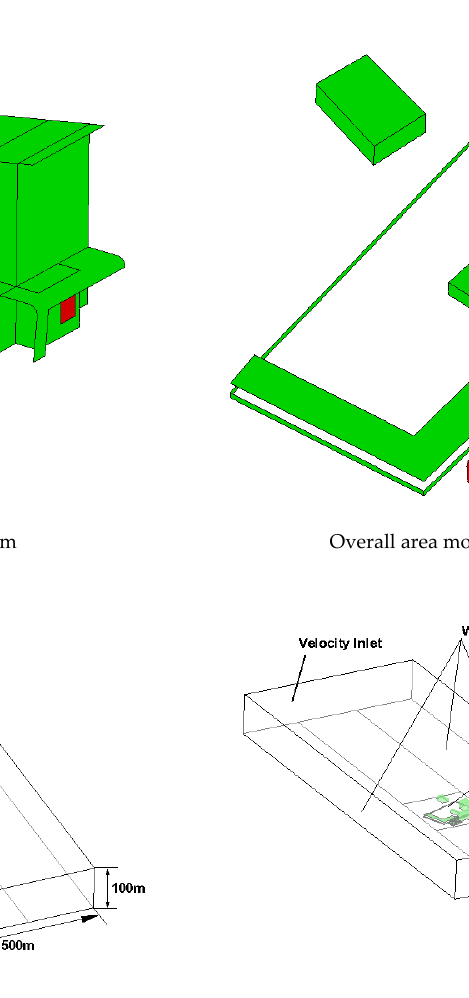
Figure 5. Architectural model of the outdoor local area and the model of the overall calculation area.